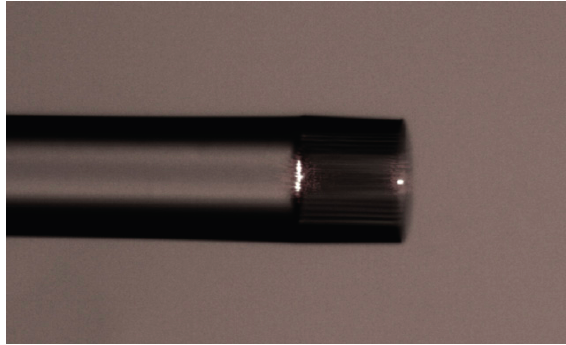
Figure 2. Microscope image of the sensor head illuminated with a He-Ne red laser.